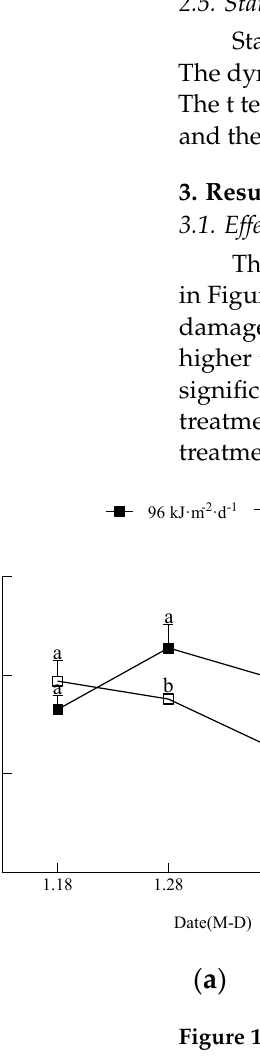
Figure 1. The effect of enhanced UV − B radiation on MDA content and the relative conductivity in leaves: ( a ) content of MDA; ( b ) the relative conductivity. Note: the symbols with a in the figure indicate significant differences between the CK and 96 kJ·m − 2 ·d − 1 treatment for the same data type; otherwise, there was no significant difference. The same scheme applies to the figures below.